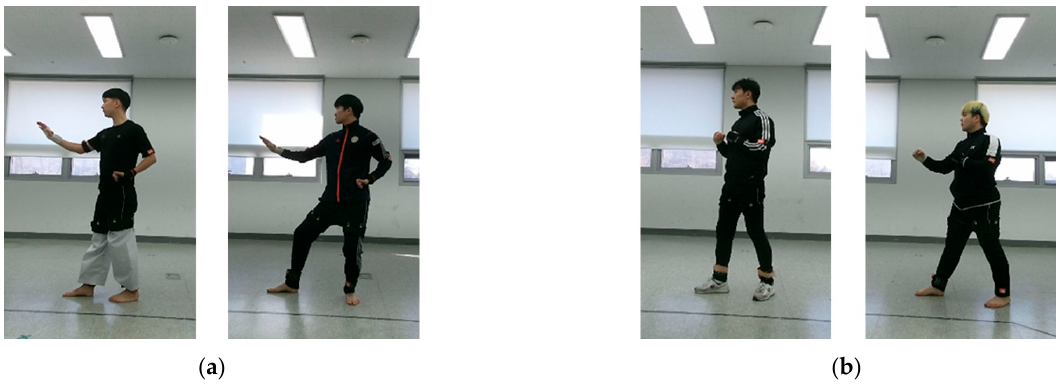
Figure 6. Differences between the subjects when performing unit techniques: ( a ) standing postures for apseogi (left, walking stance) and dwisgubi (right, back stance); ( b ) transitional actions of abchagi (front kick, A8).